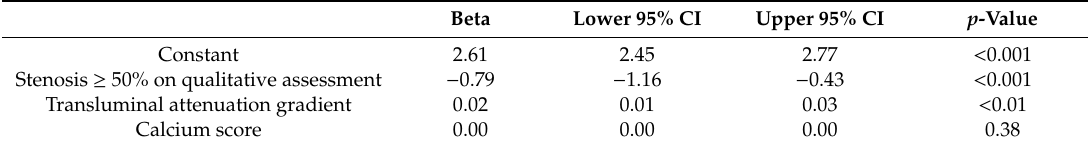
Table 3. Association between stress myocardial blood flow (MBF) and variables. Multivariate analysis.